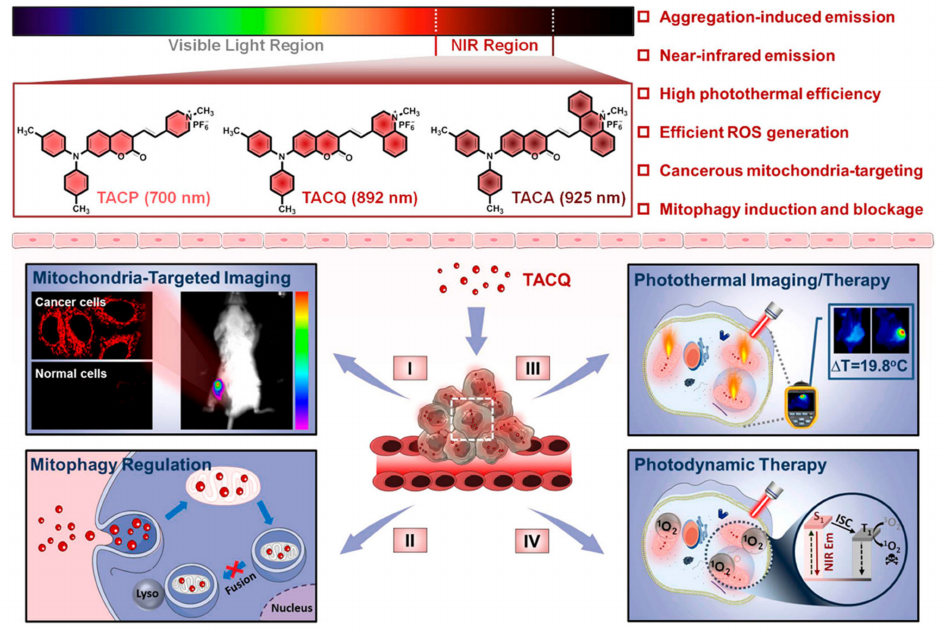
Figure 5. Schematic diagram of NIR AIEgens’ structures and their applications for fluorescence imaging-guided synergistic CT, PTT, and PDT. Adapted with permission from [102]. Copyright 2021 American Chemical